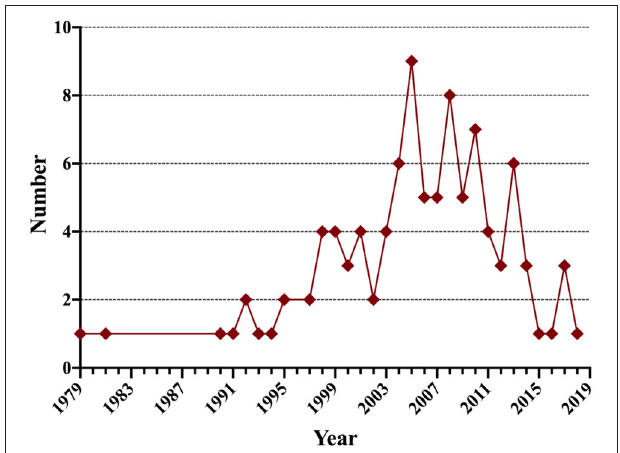
FIGURE 3 | Distribution of the top-cited articles per year.